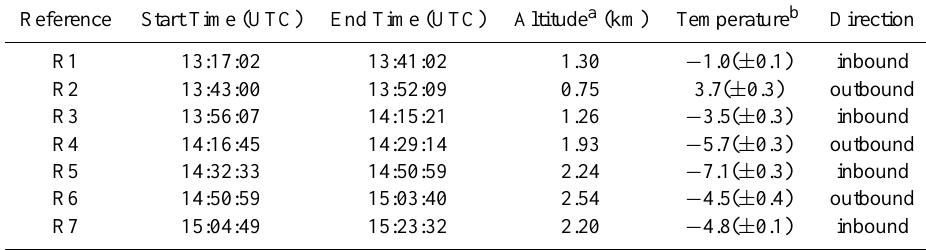
Table 1. Summary of constant altitude runs performed by the FAAM BAe146 aircraft in the operational area to the west of Chilbolton on 22 January 2009, flight reference B425, indicating start and end times of run, mean altitude and temperature of run and direction of run with respect to